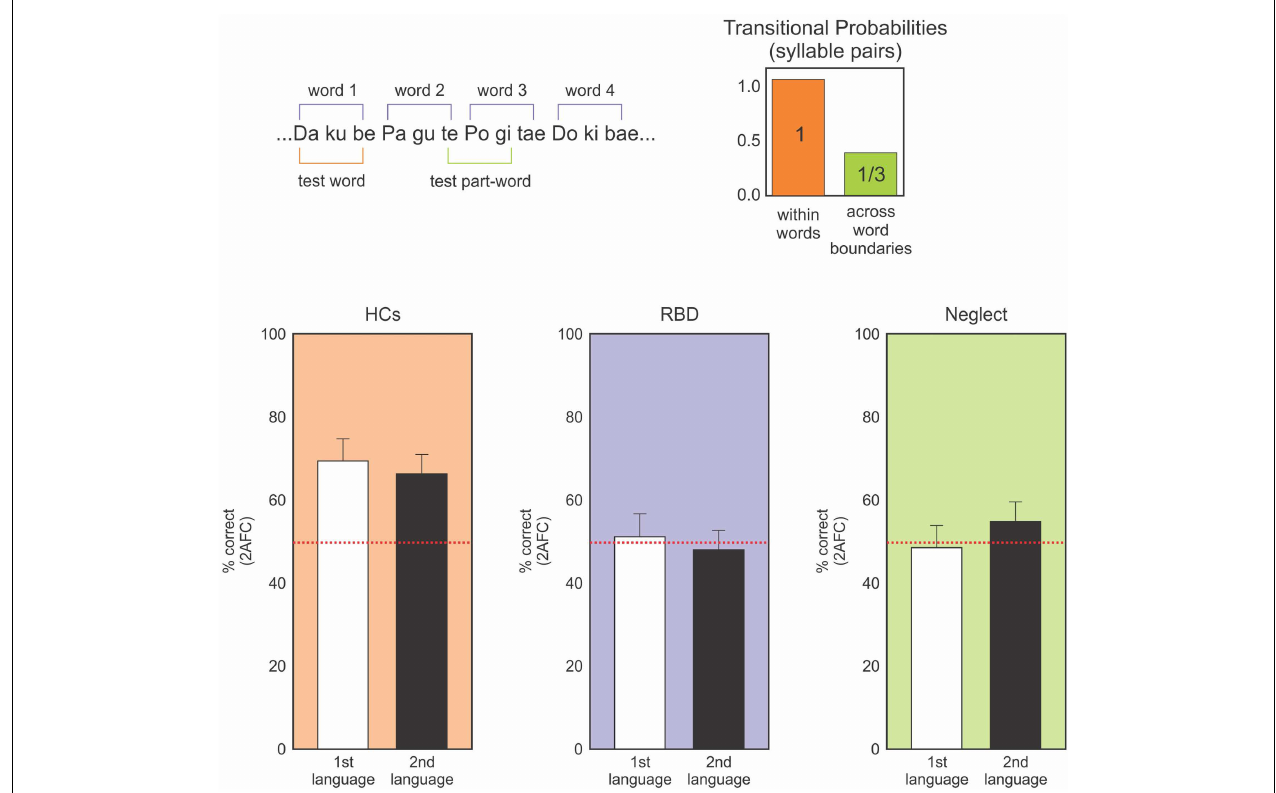
between word boundaries having 33% probability across all other syllables. Lower panels: forced-choice discrimination performance for two nonsense languages. HCs (orange) clearly perform above chance (red dotted line) on both languages. Neither the RBD (purple) or neglect (green) patients can discriminate the languages – task that was well performed by 8-month-old infants (data from Anderson and Danckert, 2013; Shaqiri et al., in